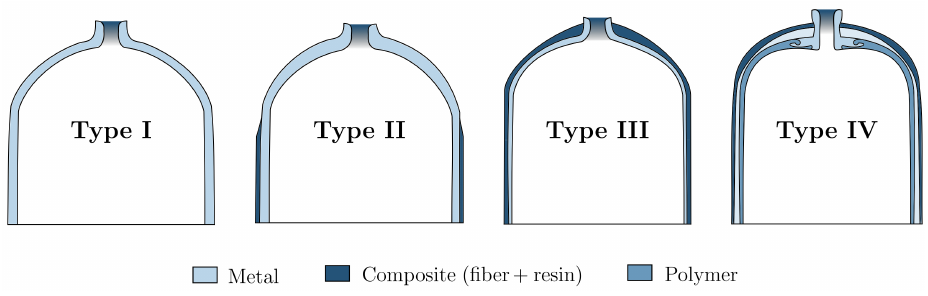
Figure 2. Different types of pressure vessels. Adapted from [8].